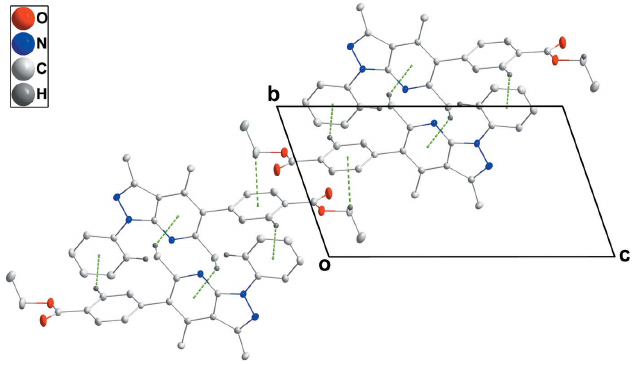
Figure 3 Packing viewed along the a -axis direction with C—H (cid:3)(cid:3)(cid:3) (cid:2) (ring) inter- actions shown as dashed lines.